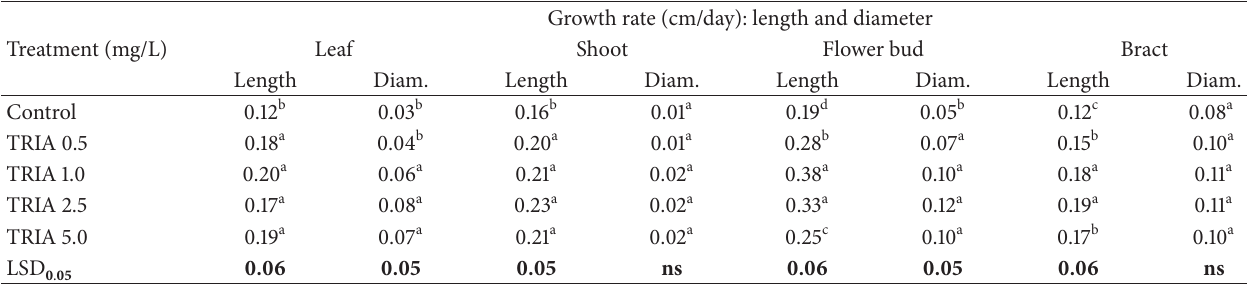
Table 1: The effects of TRIA treatments on the growth rates of leaves, shoots, flower buds, and bracts of Bougainvillea glabra under natural conditions. Growth rate (cm/day): length and diameter Treatment (mg/L) Leaf Shoot Flower bud Bract Length Diam. Length Diam. Length Diam. Length Diam.